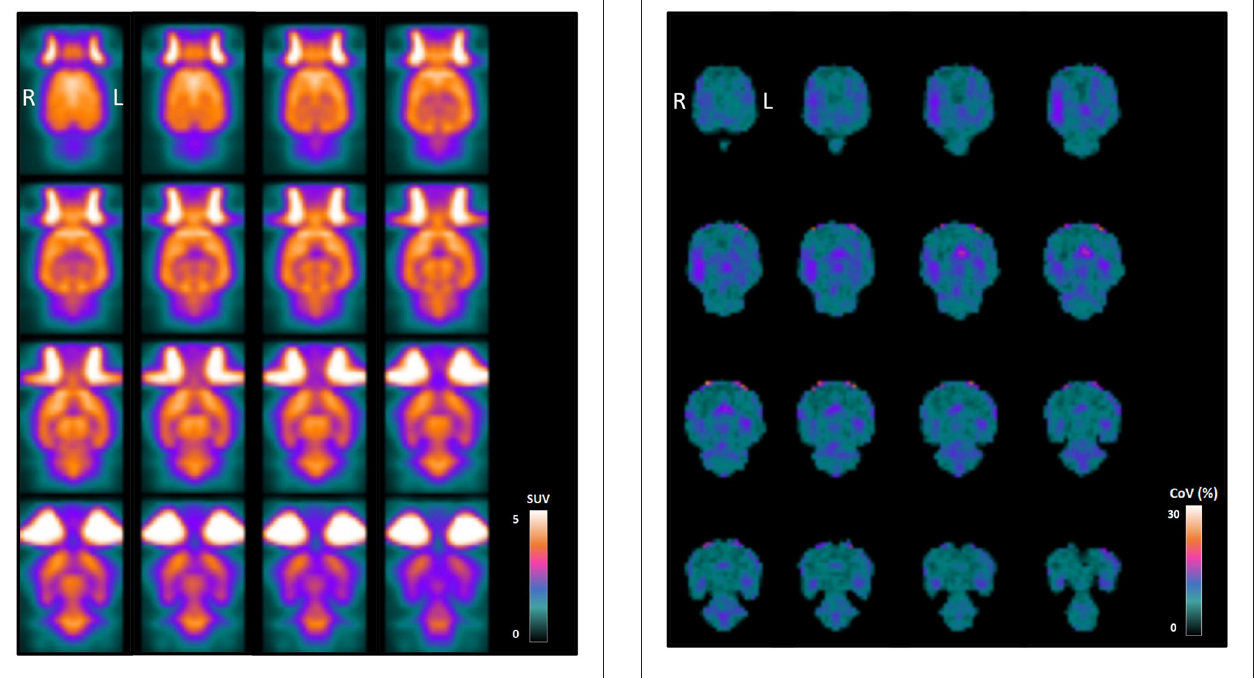
FIGURE 2 | Normal rat brain PET atlas obtained by averaging the reconstructed [18F]-FDG PET images of 28 healthy adult male Sprague-Dawley rats after cropping, Gaussian filtering, coregistration and histogram-based intensity normalization. Coronal slices are shown from dorsal (top left) to ventral (bottom right) and voxel values are presented in SUVs.